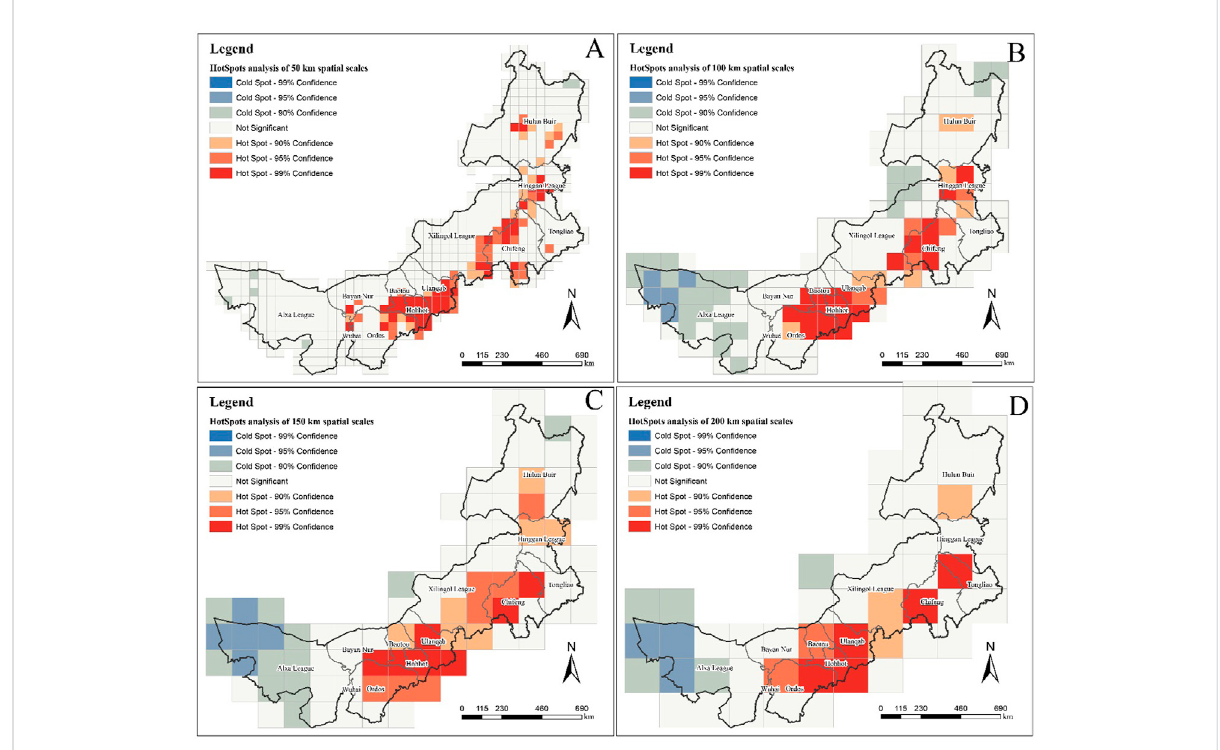
FIGURE 4 Hotspot analysis of the number of medicinal plant species at different scales. (A) is the result at the spatial scale of 50 km; (B) is 100 km; (C) is 150 km; (D) is 200